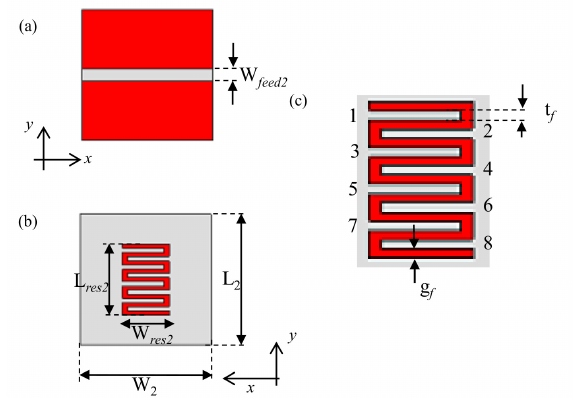
Figure 6. Geometry and design parameters of the proposed fully-textile interdigital hairpin resonator: ( a ) front view; ( b ) back view; ( c ) geometrical parameters of the fingers. c (cid:13) [2019] IEEE. Reprinted, with permission, from